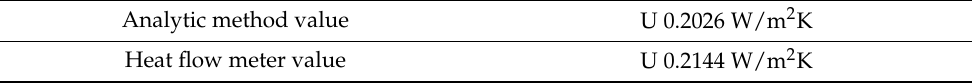
Table 10. Post operam wall thermal transmittance.